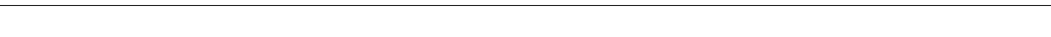
Fig. 1 myo1D controls zebra fi sh left – right asymmetry. a Transgene-mediated expression of zebra fi sh myo1D (zmyo1D) restores the laterality of genitalia rotation in Drosophila myo1D (dmyo1D) mutant or dmyo1D RNAi fl ies. Lines 3 and 6 are two independent transgenic insertions. b – e Zebra fi sh MZ myo1D mutants present defects in leftward cardiac jogging. b – d Dorsal views of the cmlc2 -expressing heart primordium at 26 hpf, anterior up. e Quanti fi cation of cardiac jogging defects in maternal (M) and maternal zygotic (MZ) myo1D tj16b or myo1D tj16c mutants. f – i Cardiac looping is affected in MZ myo1D mutants. f – h Frontal views of the cmlc2 -expressing heart at 48 hpf, dorsal up. i Quanti fi cation of cardiac looping defects in M myo1D tj16b and MZ myo1D tj16b or MZ myo1D tj16c mutants. j – m MZ myo1D mutants present defects in the leftward looping of the gut and the asymmetric development of the liver (black arrows) and pancreas (white arrows). j – l Dorsal views of foxa1 -expressing visceral organs at 48 hpf, anterior up. n , o Overexpression of zebra fi sh myo1Cb RNA impairs cardiac jogging ( n ) and looping ( o ). MZ myo1G single mutants present laterality defects ( n , o ). MZ myo1D ; MZ myo1G double mutants or MZ myo1D mutants injected with myo1Cb RNA present an increased frequency of defects compared to MZ myo1D mutants ( n , o ). Scale bars: 30 µ